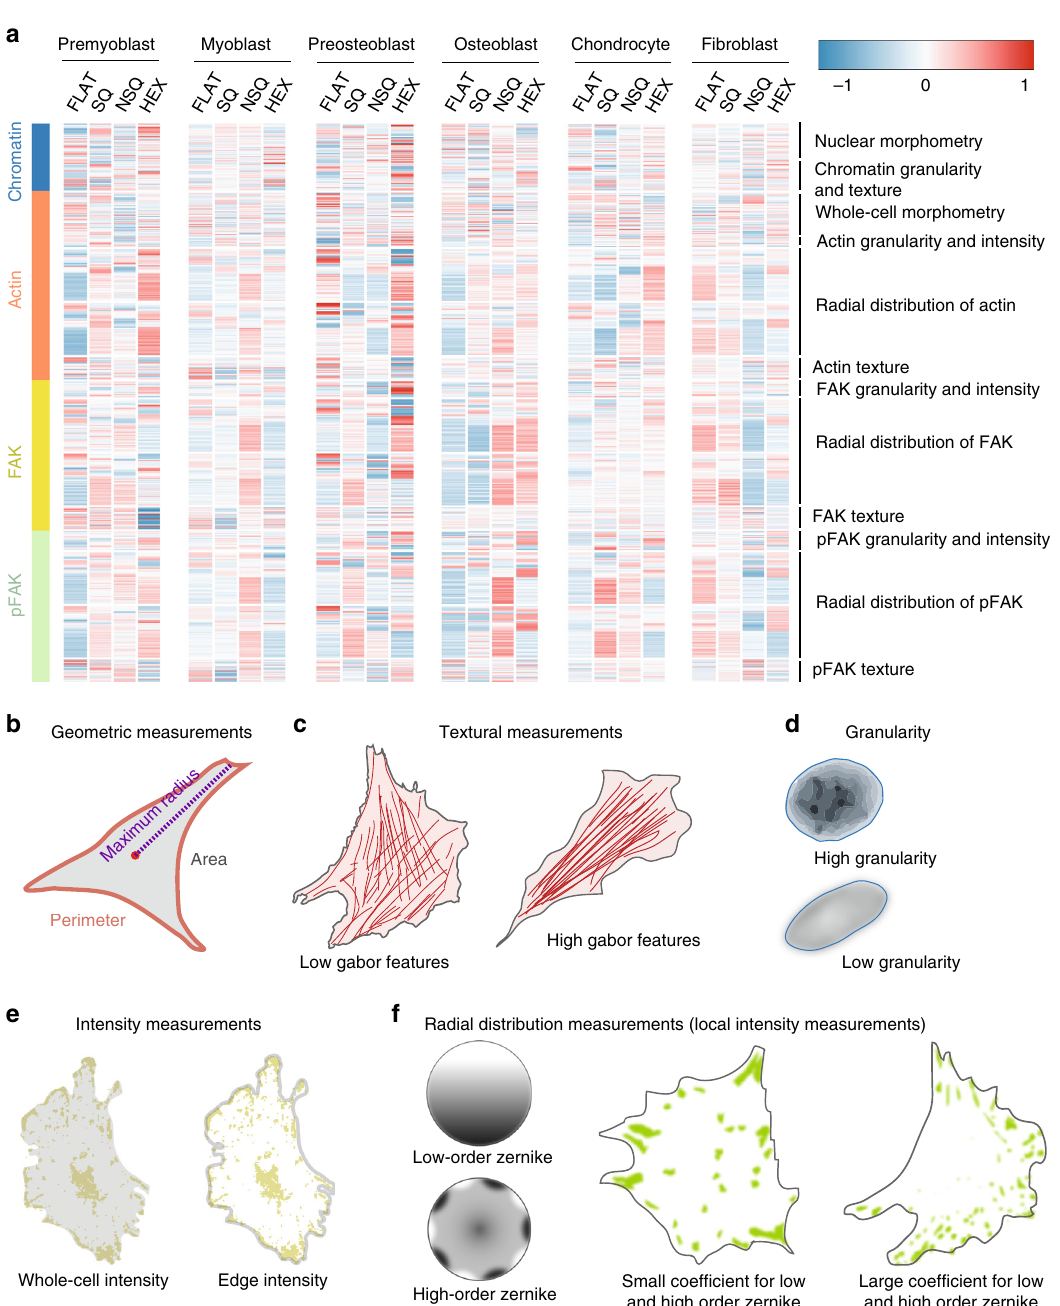
Fig. 2 Cell response to nanotopography at single-cell level. Osteoblastic, myoblastic, chondroblastic, and fi broblastic cell lines cultured on different nanotopographies were used to obtain the morphome. a Heat map of the morphome across cell types and nanotopographies. The morphome consisted of 624 features that quantitatively measure the cell and nucleus geometries, as well as chromatin, actin, FAK, pFAK characteristics within single cells (see Supplementary Data 1). Each feature has an average of 0 and a standard deviation of 1 after normalization across all cell types. The color and intensity of each tile represents the average value of the feature for a particular cell type and nanotopography combination. b – f Schematic diagrams of representative morphome